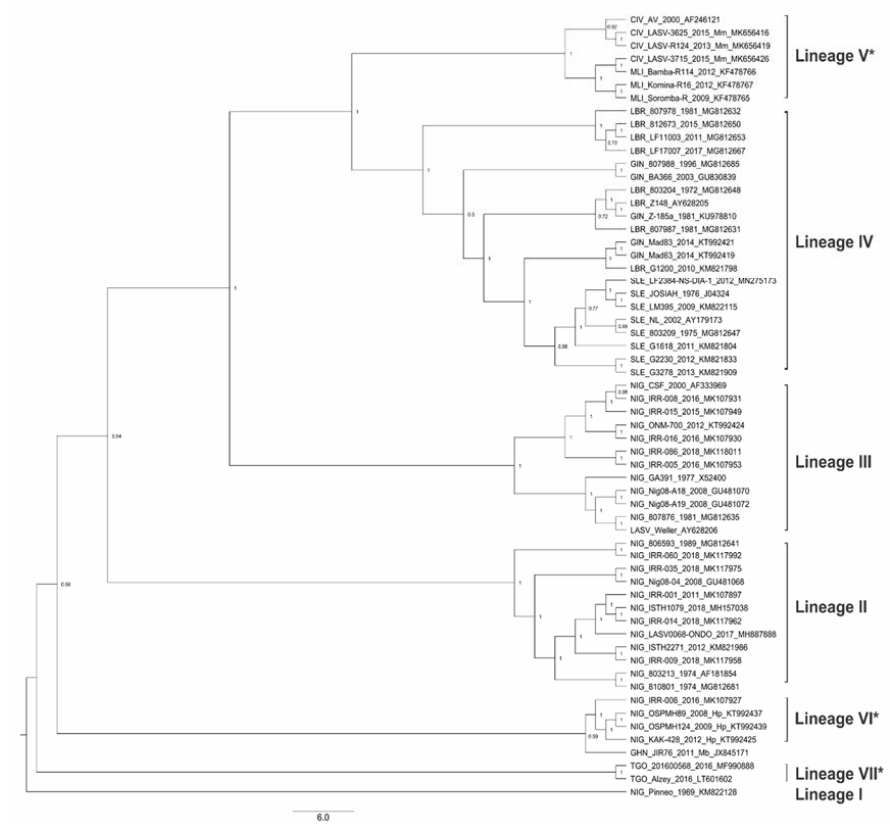
Figure 2. Maximum clade credibility tree of LASV Lineages’ glycoprotein (GP) gene. A phylogenetic analysis of the GP gene of members of confirmed and proposed (*) LASV lineages. The tree is rooted in Lineage I and each node shows the Bayesian posterior probabilities support. The tree tips are labelled to shown country, strain, year of collection, and GenBank accession numbers. Precursor glycoprotein (GPC) nucleotide sequences with greater than 60% coverage for the LASV GPC coding sequence (CDS) were retrieved from the GenBank, a maximum likelihood tree was generated in RAxML v8.2.12 [39] on CIPRES [40]. Bayesian phylogenetic inference was performed using BEAST v1.10.4 [41] with Generalized Time Reversible (GTR) plus gamma substitution model, uncorrelated relaxed clock model in lognormal distribution, SkyGrid coalescent tree prior setting, and the maximum likelihood tree as starting tree. Markov chain Monte Carlo (MCMC) chains were run for 250 million iterations, sampled every 10,000 states and 2500 trees were discarded as burn-in, to obtain an e ff ective sample size (ESS) > 200 for all parameters. Maximum clade credibility tree was drawn in Tree Annotator v1.10.4